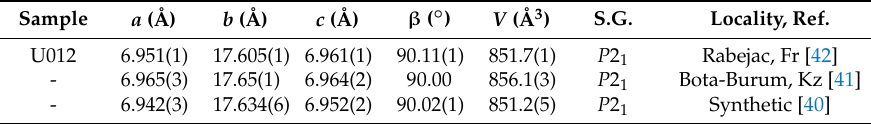
Table 8. Refined unit-cell parameters of